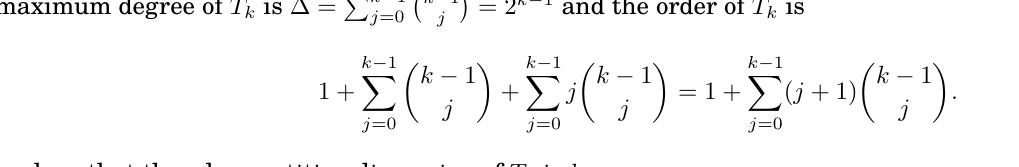
for k = 3 with maximum degree ∆ = 2 k − 1 = 4 , order 1 + (cid:80) k − 1 k